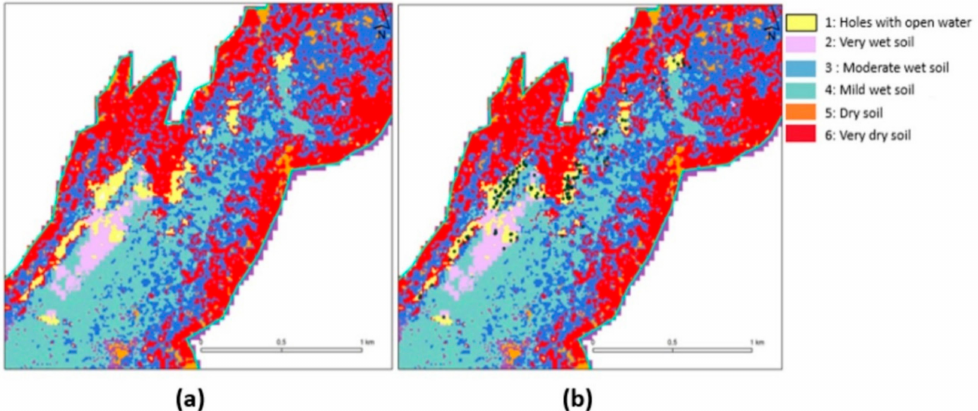
Figure 12. ( a ) Random forest classification applied to the 11 multibands dataset of 2017, and ( b ) the same image superposed to the position of the water